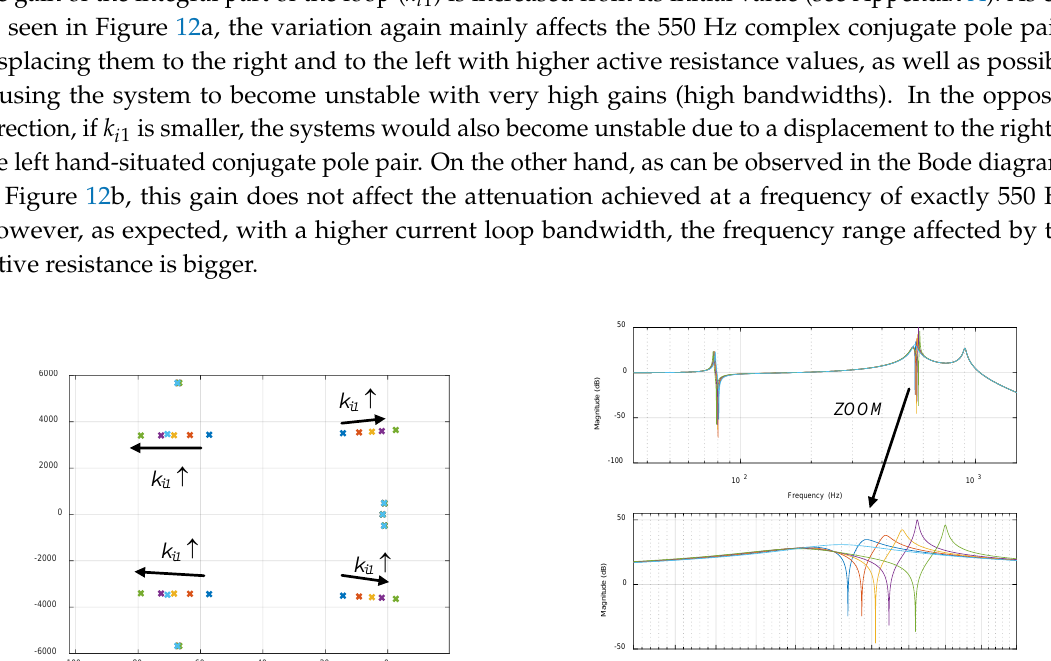
Figure 11. Dominant poles and Bode plots of the voltage at the Pcc with different active resistances ( R v 1 = 7.562 k Ω multiplied by factors of (1 0.75 0.5 0.25 0.15 0.1 0.075 0.05)) programmed at 550 Hz. ( a ) Dominant poles of the system, ( b ) Bode plot of v 3 αβ ( s )/ v sαβ ( s ).